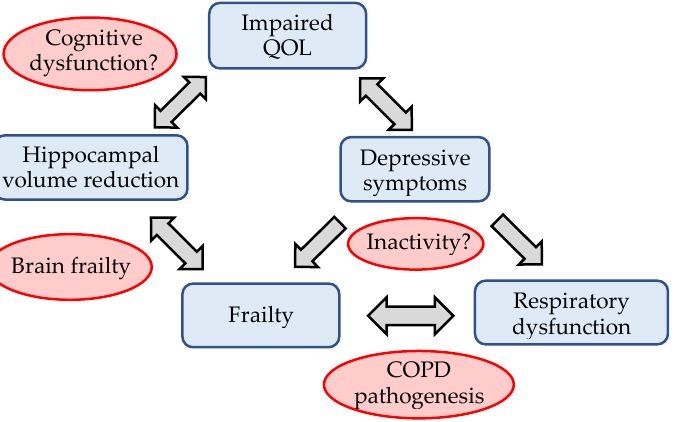
Figure 3. Association between QOL, frailty, depressive symptoms and hippocampal volume in patients with COPD. “Cognitive dysfunction” and “Inactivity” are presumption for future studies.